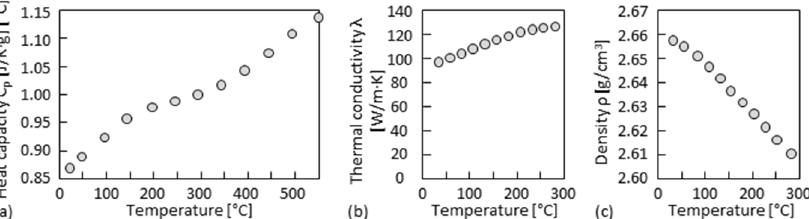
Figure 20. Material property data used in the simulation: ( a ) heat capacity; ( b ) thermal conductivity; ( c ) density.